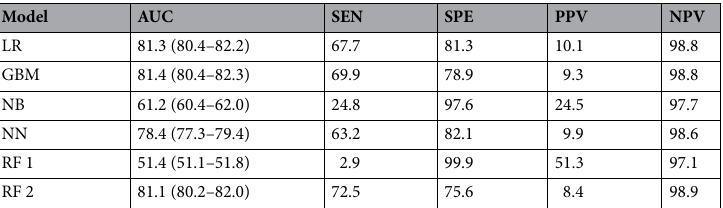
Table 3. Model performances for frequent users 5. GBM gradient boosting machine, LR logistic regression, NB naïve bayes, NN neural network, RF random forests (1: binary outcome, 2: continuous outcome). AUC area under the curve, SEN sensitivity, SPE specificity, PPV positive predicted value, NPV negative predicted